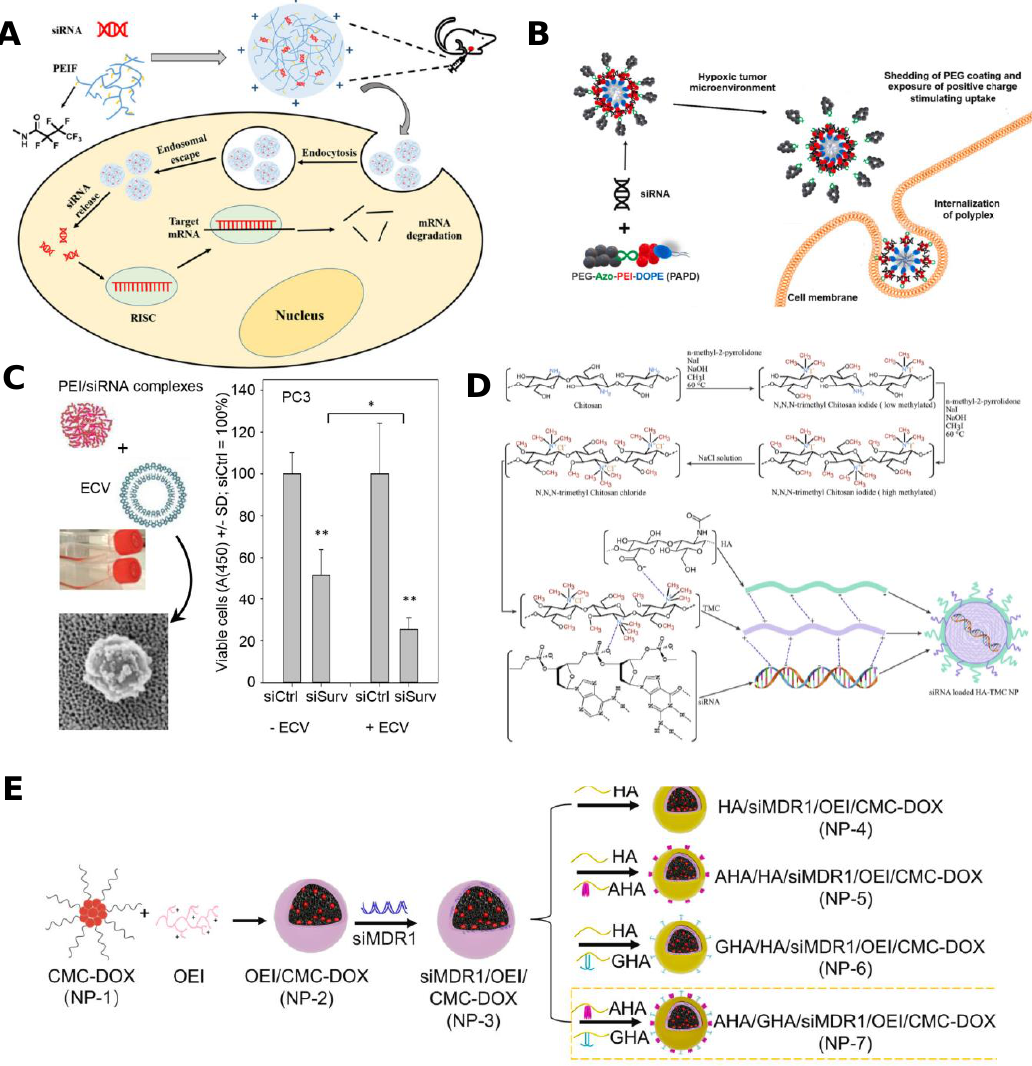
Figure 2. ( A ) The formation process of PEIF/siRNA complex and its application in tumor cells. Fluor- inated PEIF was synthesized by forming an amide bond between PEI and heptafluorobutyric anhy- dride. The complex system formed by the combination of PEIF and nucleic acid is stable and easy to be taken up by cells, with high endosomal escape efficiency and gene silencing ability [66]. Cop- yright 2020, Springer Nature. ( B ) Schematic illustration shows the PAPD-siRNA and its mode of action in tumor cells. When PAPD nanoparticles are extravasated into tumor tissue, the hypoxic microenvironment causes bio-reducing cleavage of azo adaptor in the activated PAPD complex, resulting in shedding of PEG layer and exposure of the positive charged PEI previously shielded by PEG. This leads to increased uptake of nanoparticles by tumor cells [67]. Copyright 2020, Elsevier. ( C ) Production and therapeutic effect of PEI/siRNA nanoparticles modified by ECVs. ECV-modified PEI/siRNA complex targeting survivin increased inhibition of PC3 prostate cancer cells Tumor growth curves showed that tumor growth was significantly inhibited by approximately 45% in the treated group [68]. Copyright 2020, Elsevier. ( D ) TMC synthesis steps and schematic diagram of siRNA loaded HA-TMC NP [26]. Copyright 2020, Elsevier. ( E ) The fabrication process of siMDR1/DOX co-delivery nanosystems. The nanoplatform consists of three components: the redox-